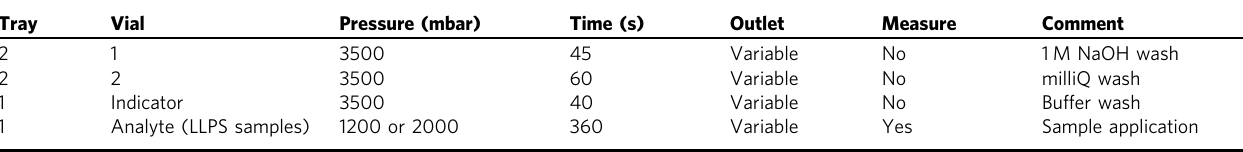
Table 4 Experimental parameters for HTP screen of α -Syn LLPS on the FIDA 1 instrument.